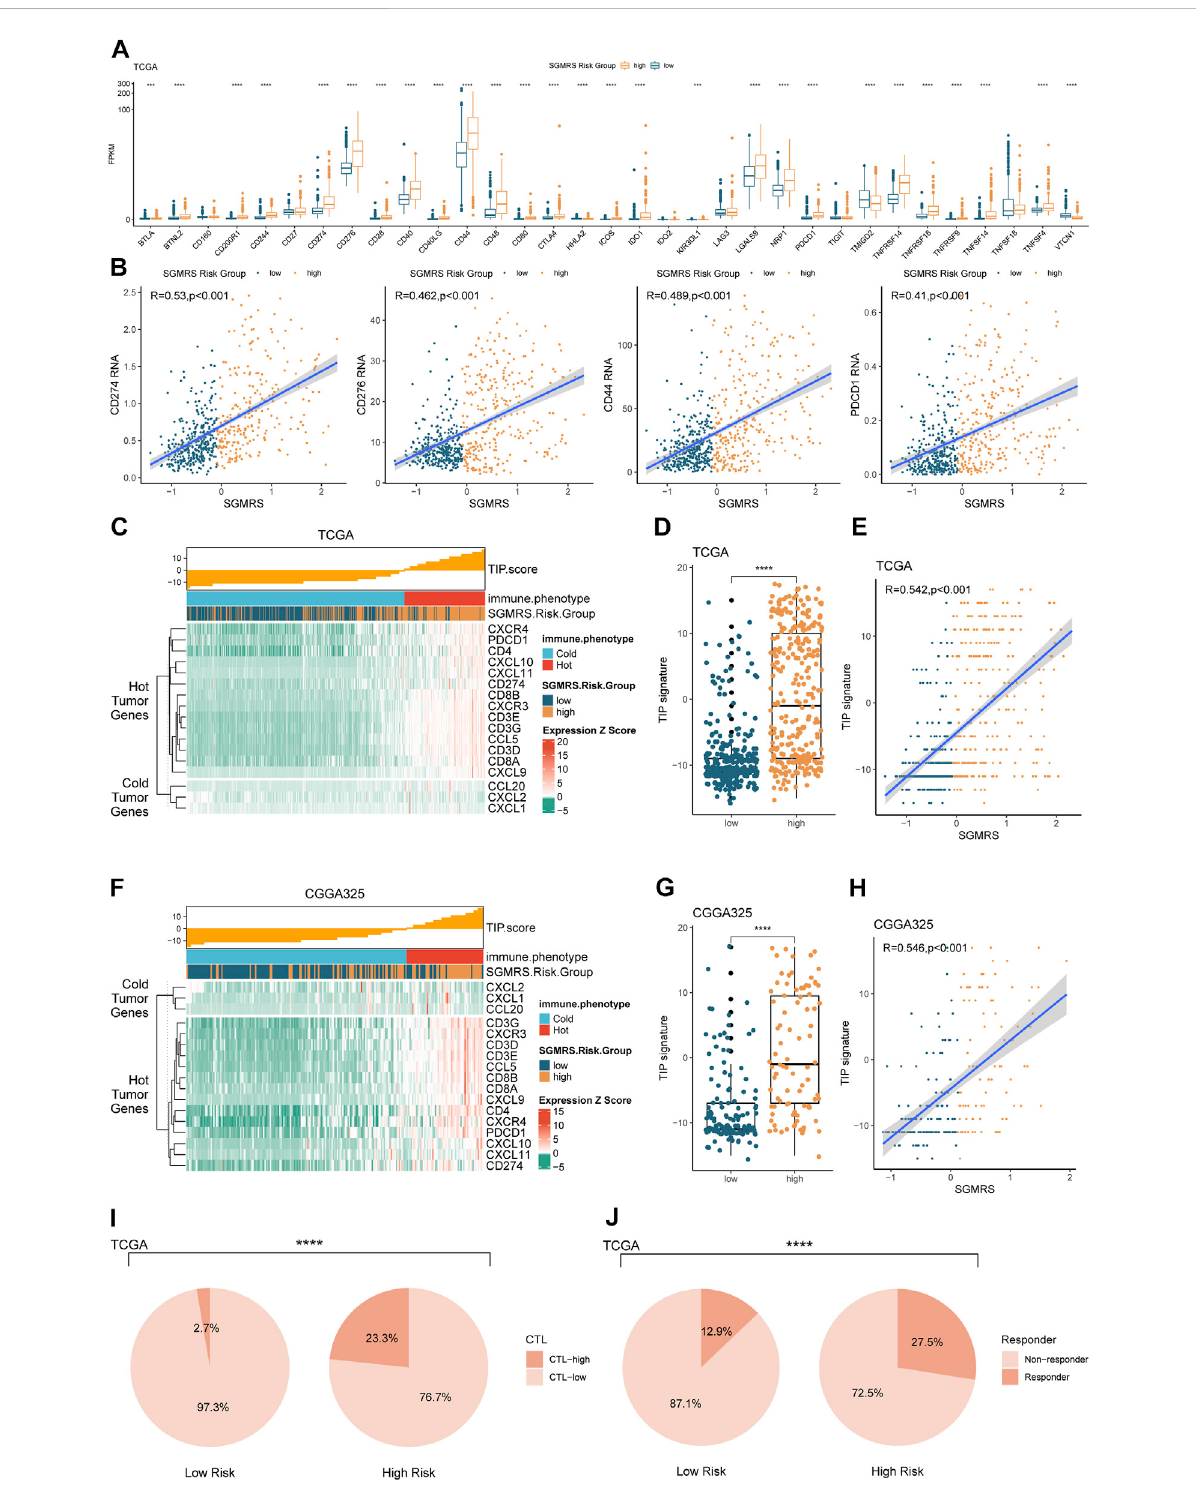
FIGURE 9 Differences in expression of immunotherapy-related genes, immunological phenotype, and response to ICIs between two SGMRS risk groups. (A) Boxplot for the expression level of 33 immunotherapy-related genes in two risk groups in TCGA cohort. (B) Analyses of correlations between SGMRS and the expression levels of CD274, CD276, CD44, and PD-1 in TCGA cohort. (C) Analysis of TIP score and related gene expression levels ordered by SGMRS in TCGA cohort. (D) Difference in TIP score between two risk groups in TCGA cohort. (E) Analysis of correlation